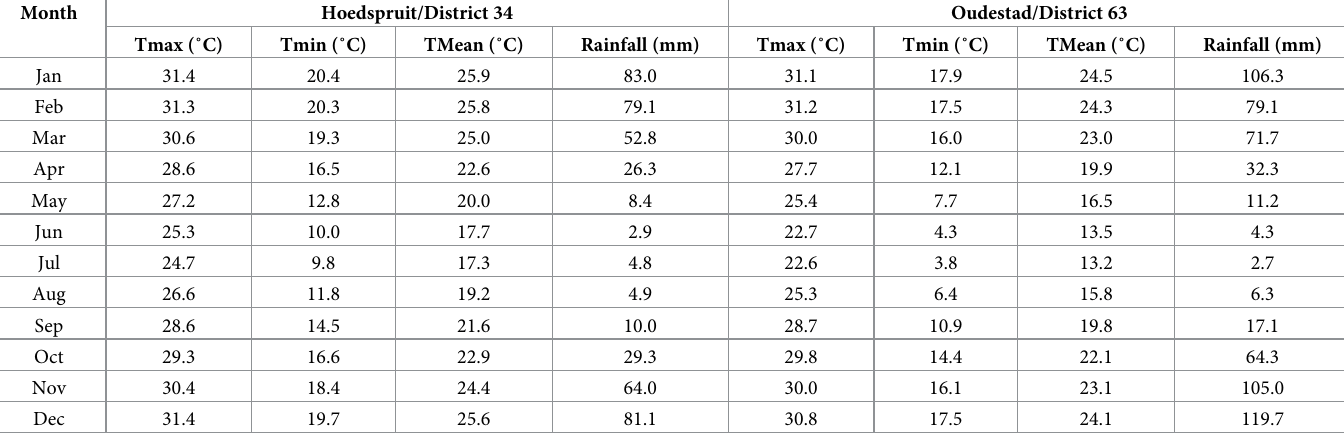
Table 4. Mean monthly values of Maximum temperature (Tmax), Minimum temperature (Tmin), Average Temperature (Tmean) and total rainfall over the period of study